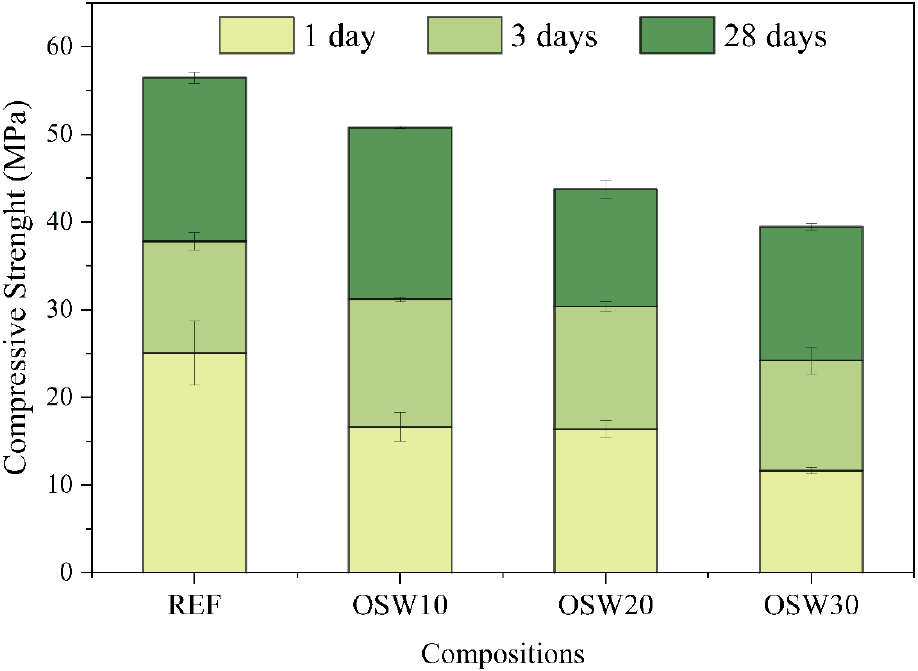
Figure 9. Compressive strength of cement pastes at 1, 3, and 28 days.